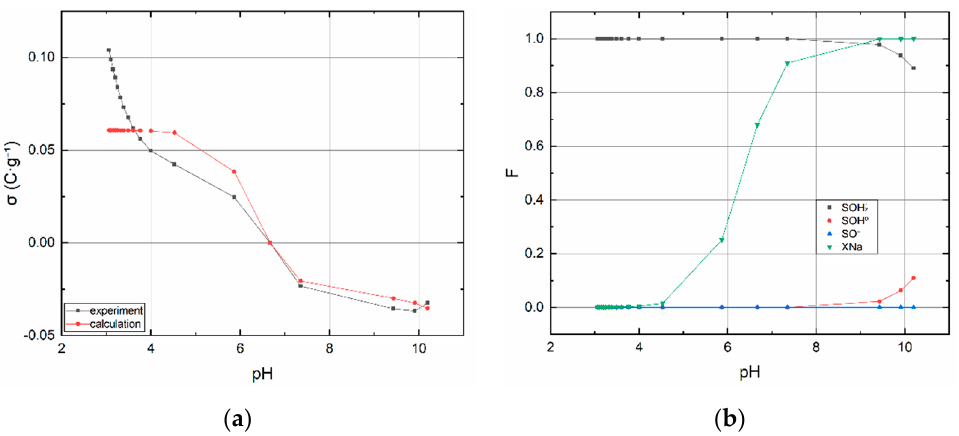
Figure 3. BC1 ( a ) Surface charge dependence on pH and ( b ) species’ mole fraction dependencies on pH. Chemical Equilibrium Model (CEM) and Ion Exchange (IEx) models were used.